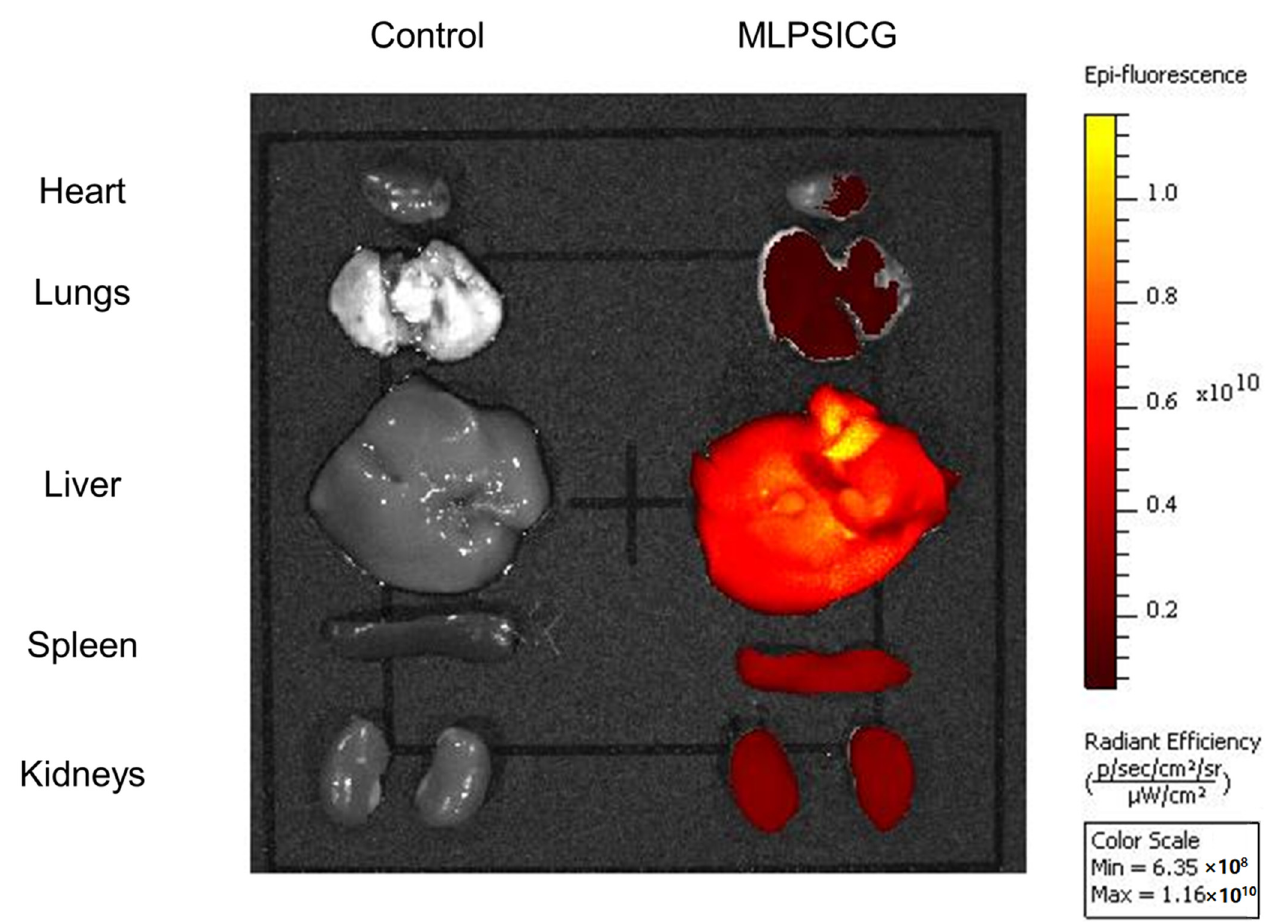
Figure 6. Representative samples of ex vivo organs demonstrating biodistribution of MLPSICG. ICR mice weighing 25 ± 3 g received an injection of 200 µ L of MLPSICG suspension in the tail vein, while controls received the equivalent volume of normal saline. The animals were euthanized at 30 min post-injection, followed by isolation and fluorescent image analysis of the heart, lungs, liver, spleen, and kidneys. Table 2. Numerical characteristics of the distribution of fluorescence in organs. Organs